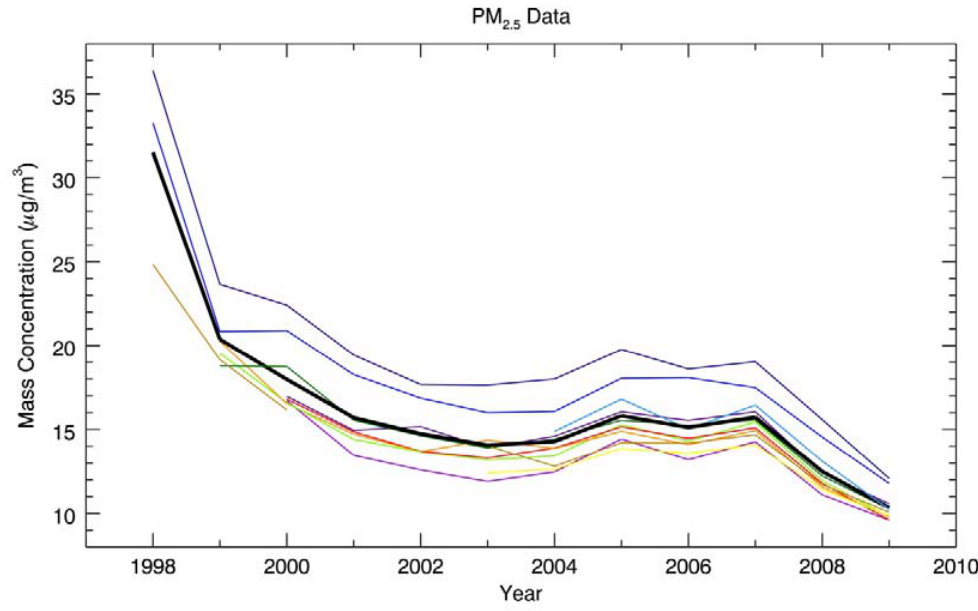
trends since monitoring began in 1998 for all stations in the study Figure 3. PM 2.5